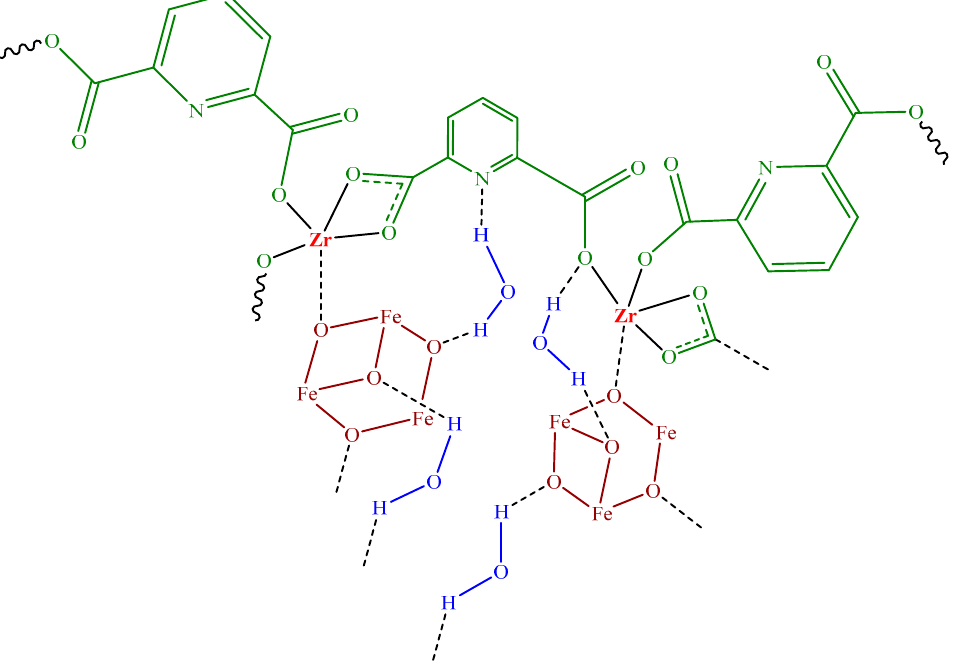
Figure 6. Suggested structure for zirconium magnetic nanocomposite.